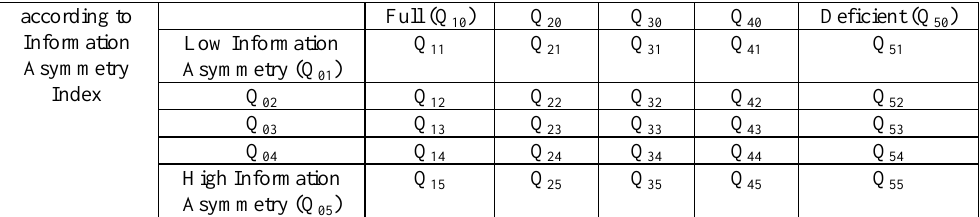
Table1. Quantilization of companies based on Corporate Governance Point according